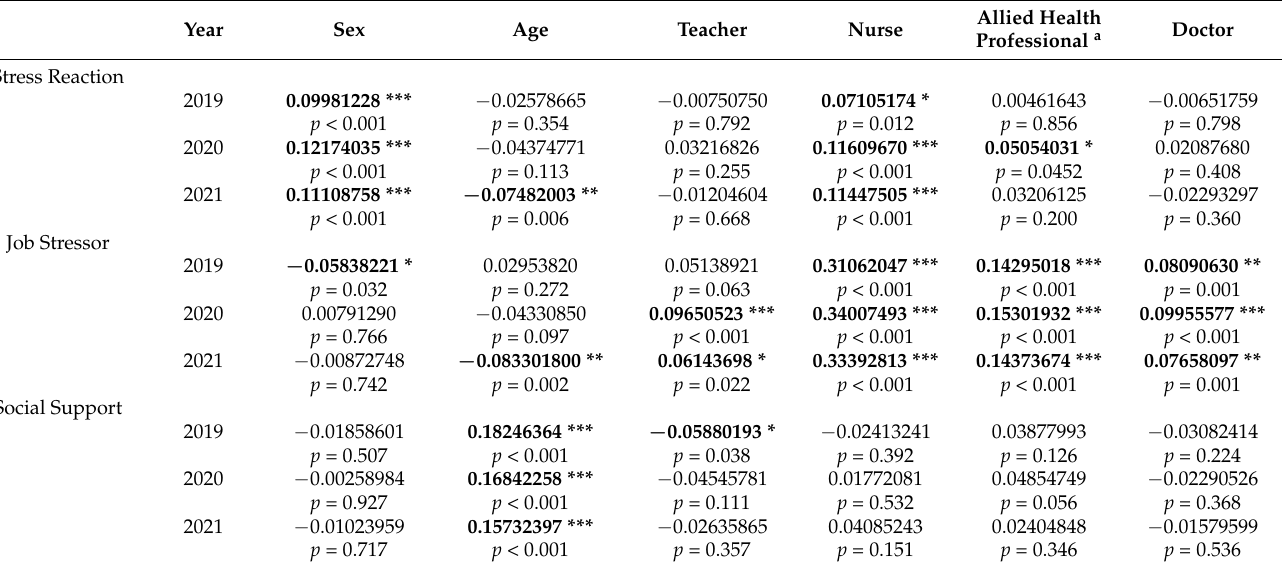
Table 2. Multiple regression analyses of university staff before and during the COVID-19 pandemic each